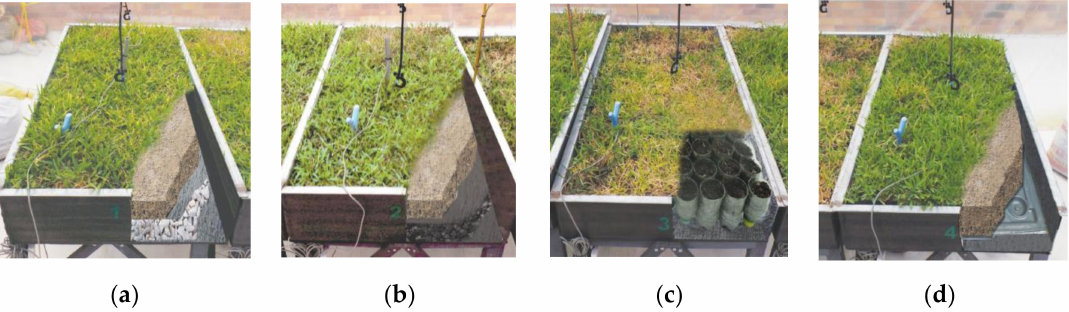
Figure 2. Cross-section detail of roofing prototypes: ( a ) Prototype 1: basalt gravel. ( b ) Prototype 2: recycled rubber. ( c ) Prototype 3: recycled polyethylene (PET) bottles. ( d ) Prototype 4: recycled high density polyethylene (HDPE)